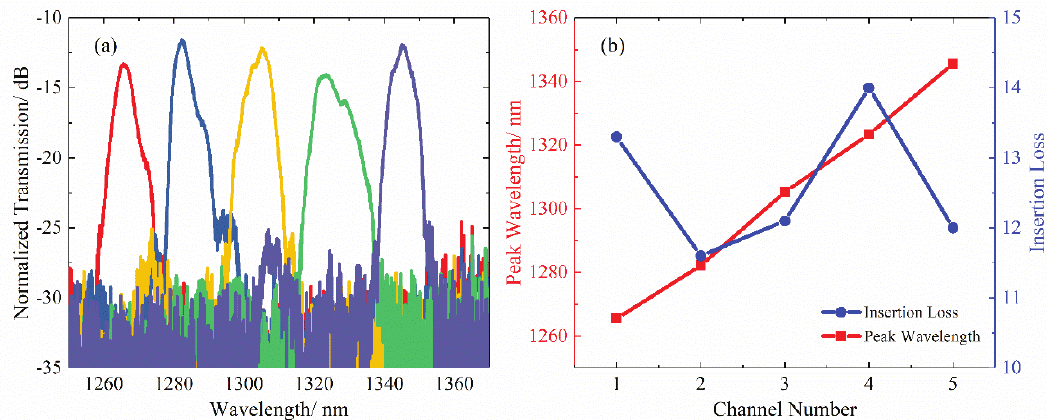
Figure 7. ( a ) The measured transmission spectrum of the AWG; ( b ) The peak wavelength and insertion loss of 5 channels.